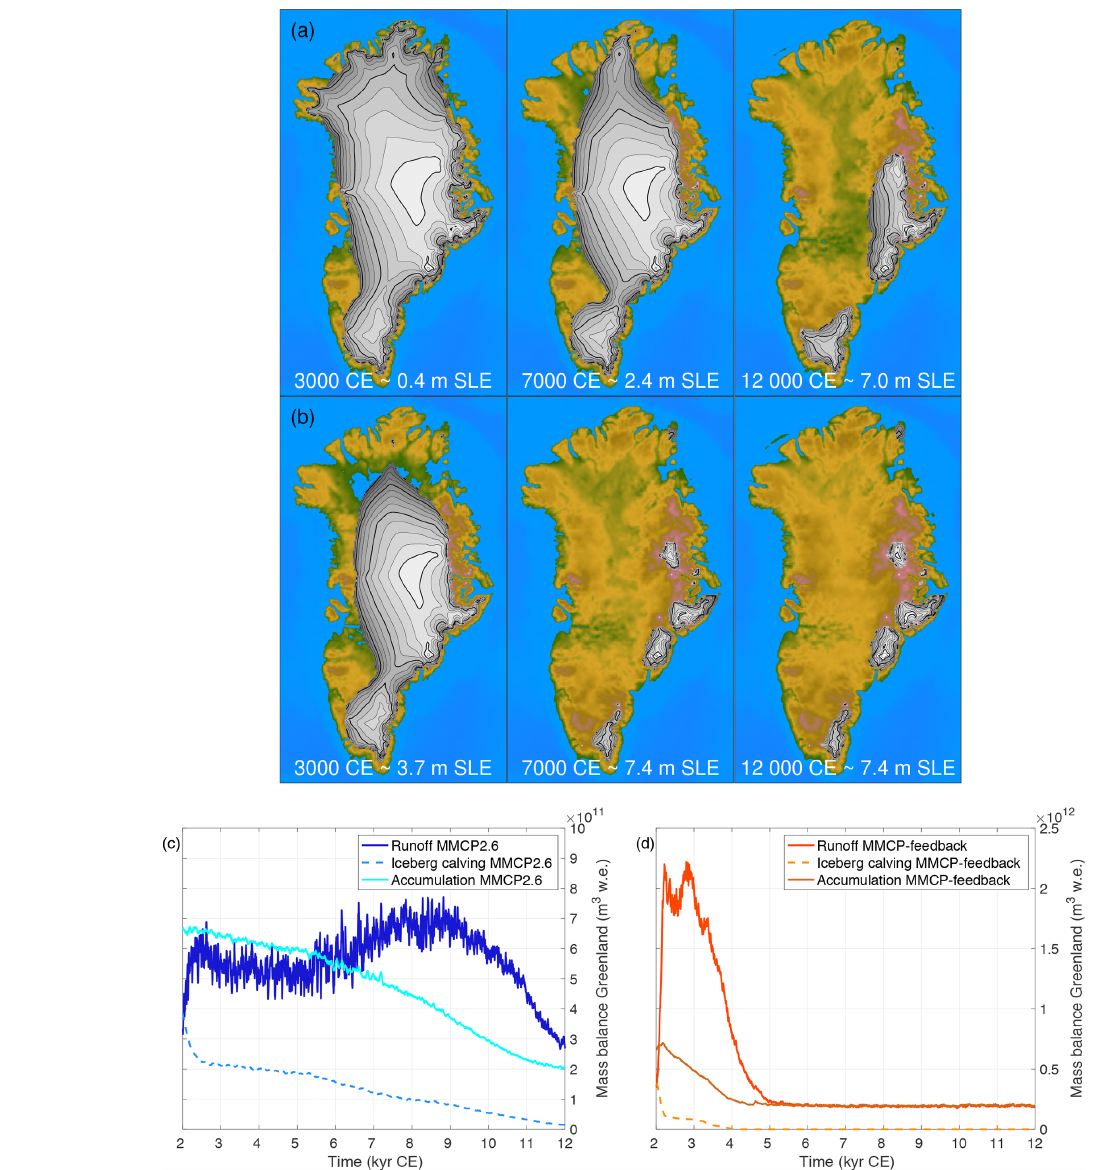
Figure 7. (a) Greenland ice sheet configuration at 3000CE, 7000CE, and 12000CE using scenario MMCP2.6 and (b) MMCP-feedback. Main mass balance components explaining the change in ice sheet geometry for scenarios MMCP2.6 (c) and MMCP-feedback (d) . Note that the land–sea mask has not changed due to the change in GMSL but only due to isostatic